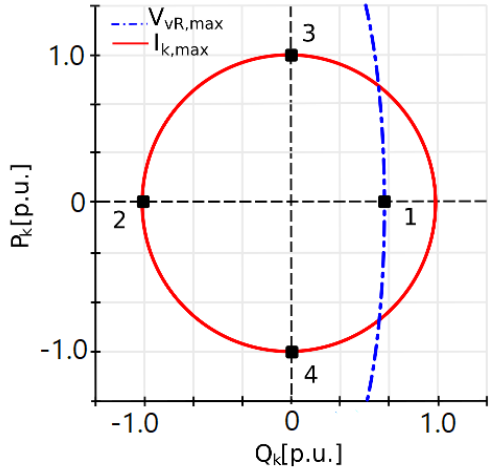
Figure 2. PQ curves at the GVSC.